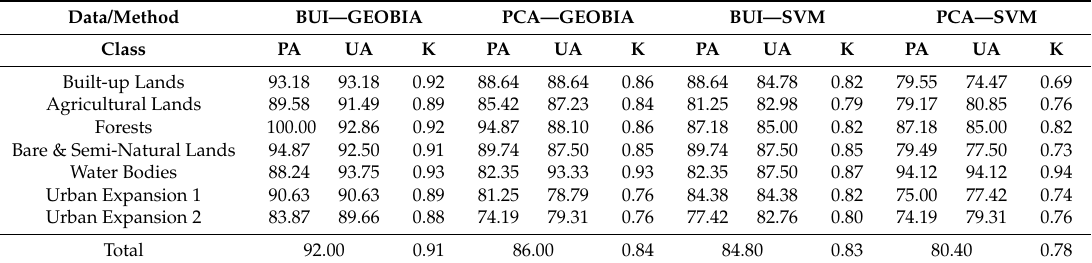
Table 4. Point-based accuracy results (PA: Producer Accuracy; UA: User Accuracy; K: Kappa).